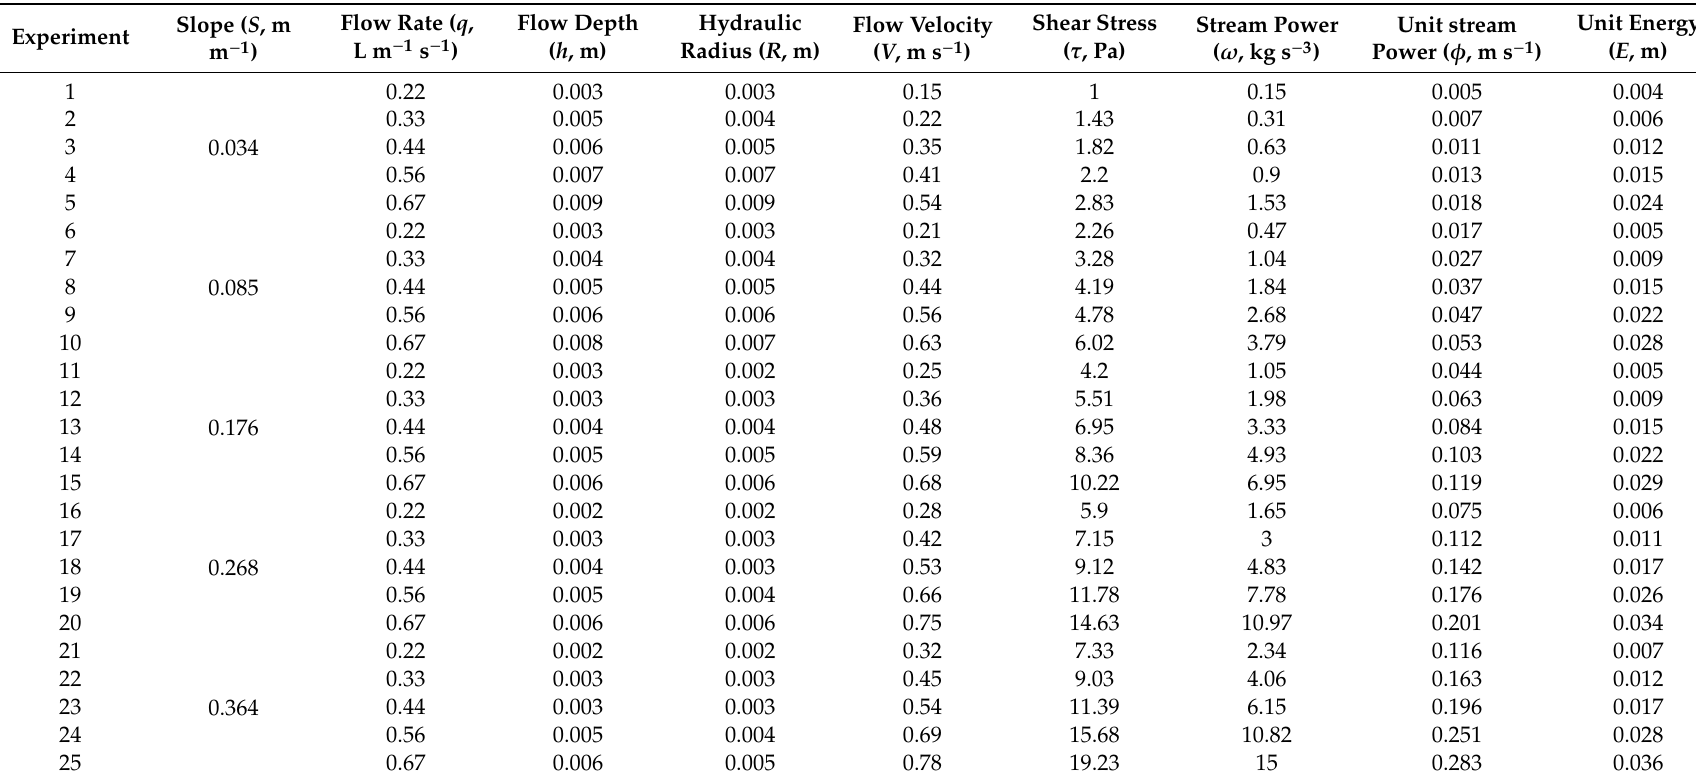
Table 1. Flow characteristics in the experiments carried out for measuring the rill detachment capacity under four land uses in the Saravan watershed (Northern Iran).